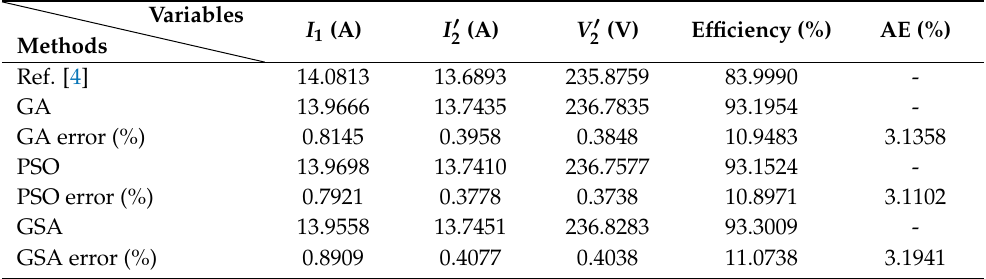
Table 3. Electrical variables at full load of a single-phase transformer 4 kVA, 250–125 V at 50